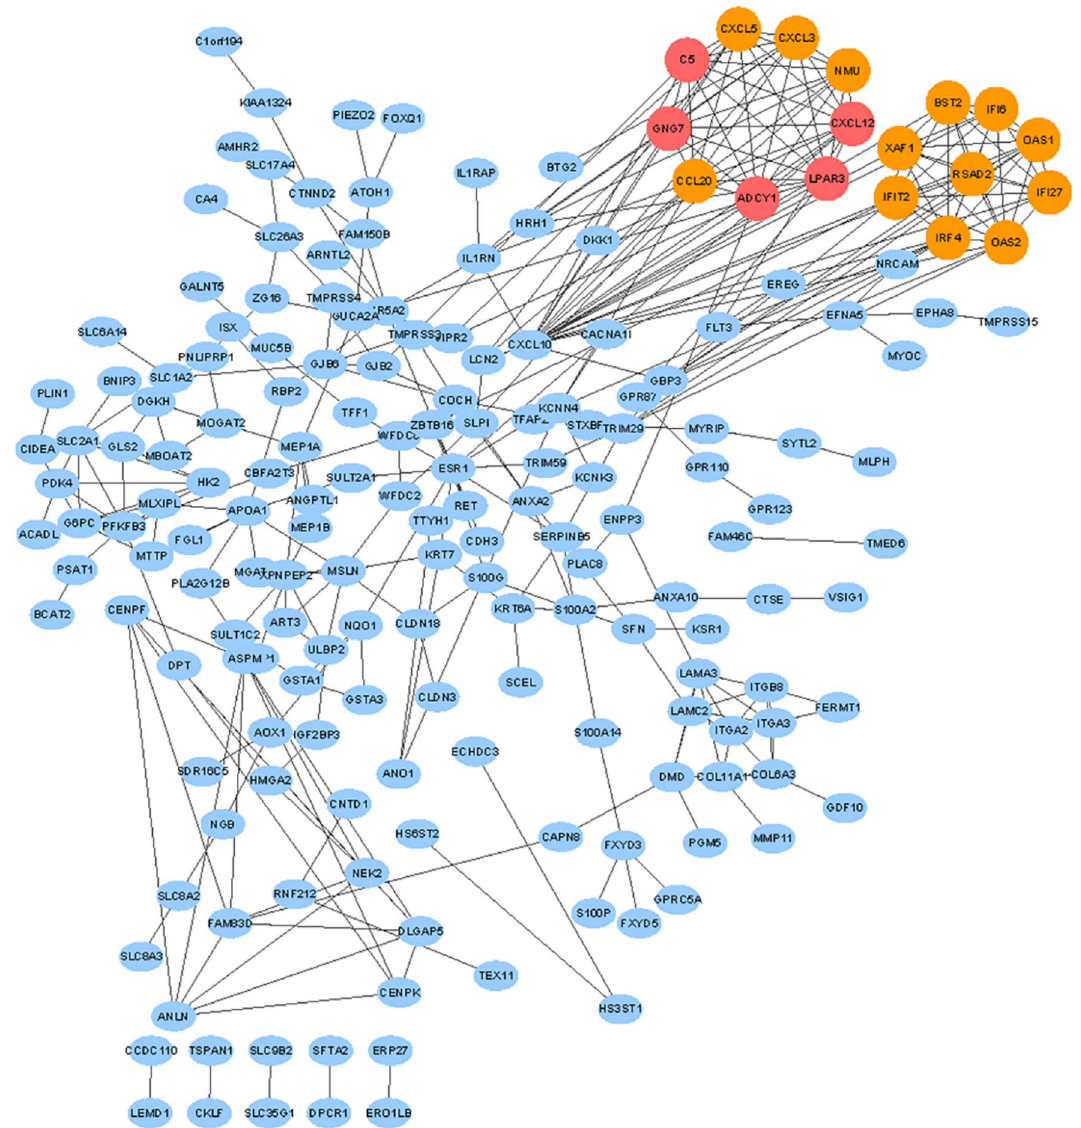
Figure 2. PPI networks of DEGs. Based on the STRING online database, 186 genes/nodes were filtered into the DEG PPI network and visualized by Cytoscape software (version 3.7.2). The two highlighted circle areas are the most significant modules. upregulated DEGs are represented by orange circles and downregulated DEGs are represented by red